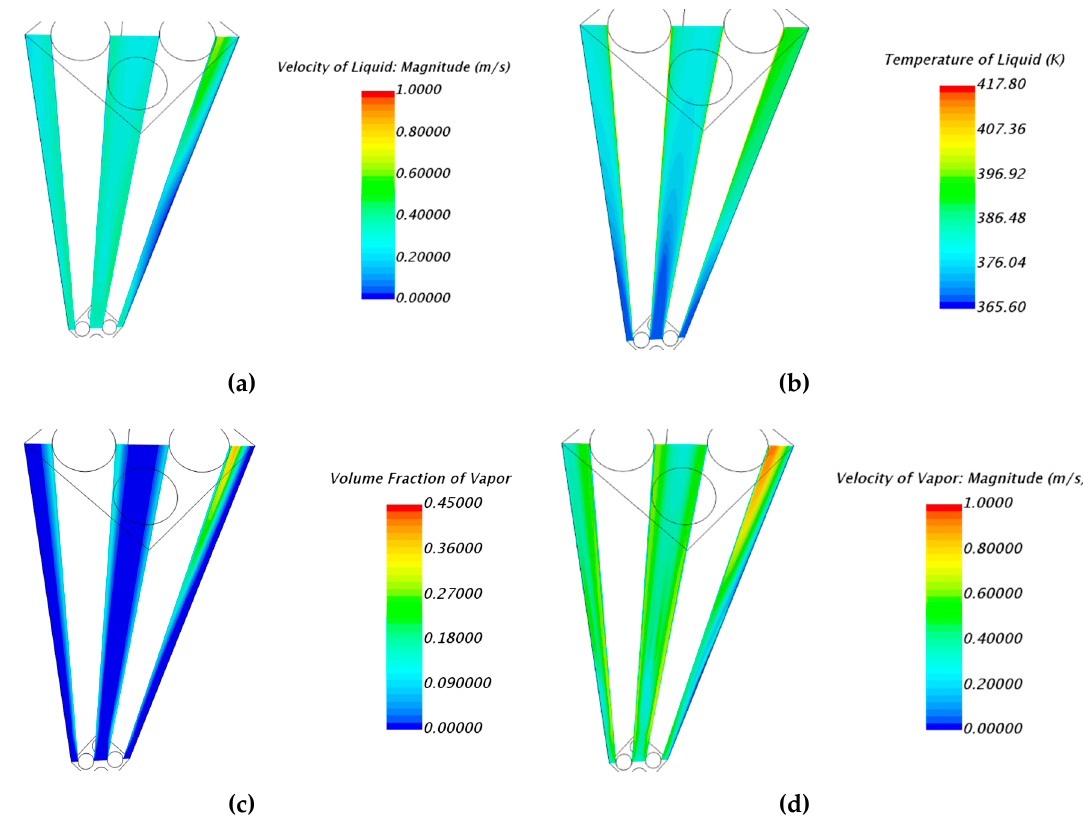
Figure 15. Distribution contour in Case 5: ( a ) velocity of liquid, ( b ) temperature of liquid, ( c ) volume fraction, and ( d ) velocity of vapor on the vertical plane at the wall edge.